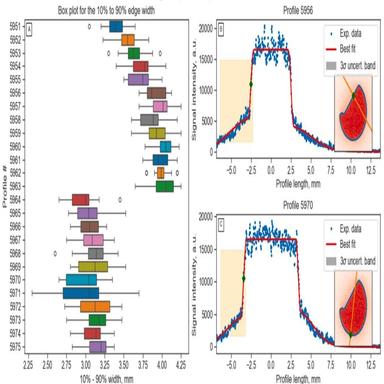
Effect of the edge shape on the 10% to 90% edge width of a natural UO2 sample as illustrated by a box plot of intensity profiles (A). Profiles from 5951 to 5963 represent the straight side (B), while profiles from 5964 to 5975 showcase the curved side (C).